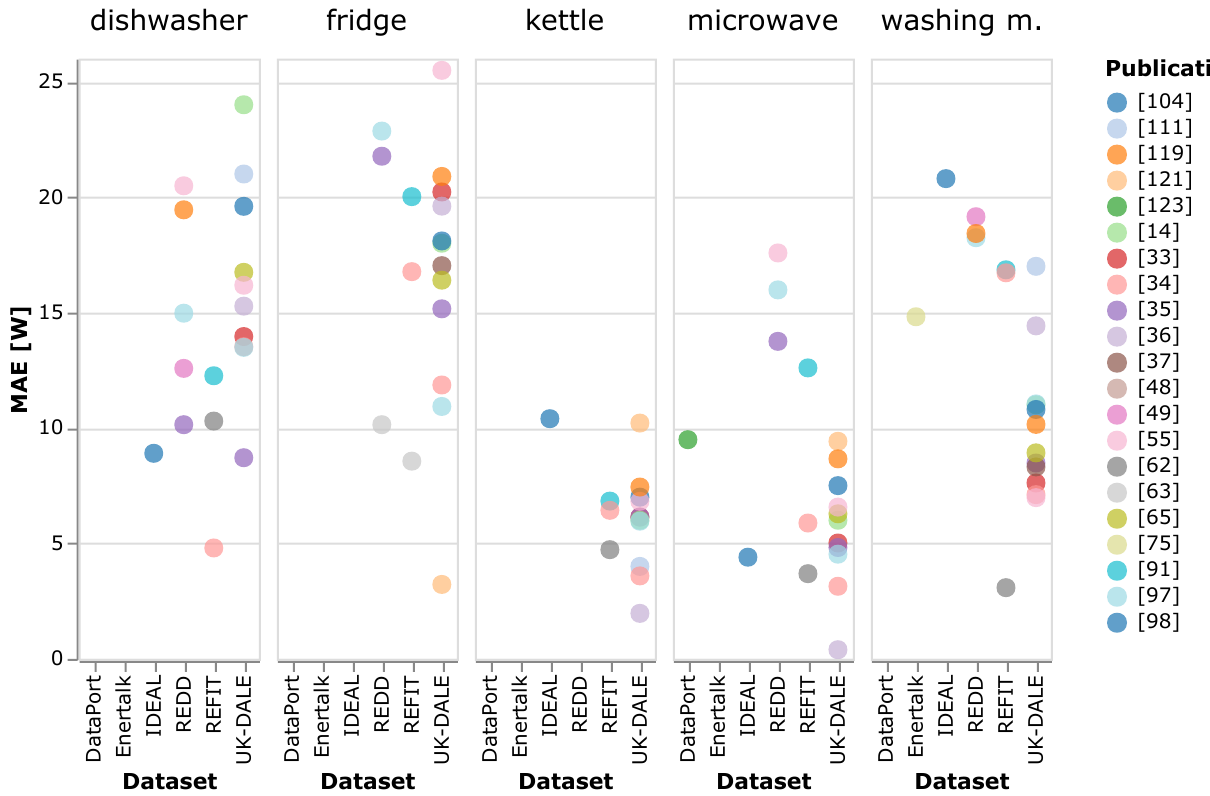
Figure 3. Minimal reported MAE for the corresponding dataset and appliance. Only results from the observed , unseen evaluation scenario have been included. Only approaches proposed by the authors in the corresponding publications are taken into consideration (i.e., no baselines or models from the state-of-the-art). Results have been split according to the appliance and employed dataset. Please note that appliances with a single result in the selected range are not